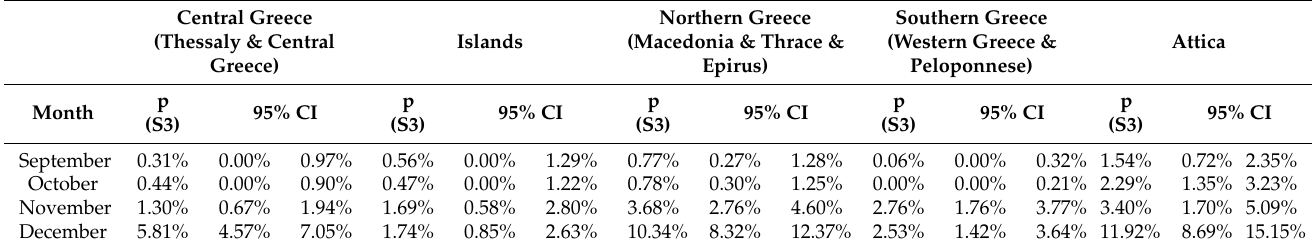
Table 2. Monthly seropositivity (S3) in five major geographical units.